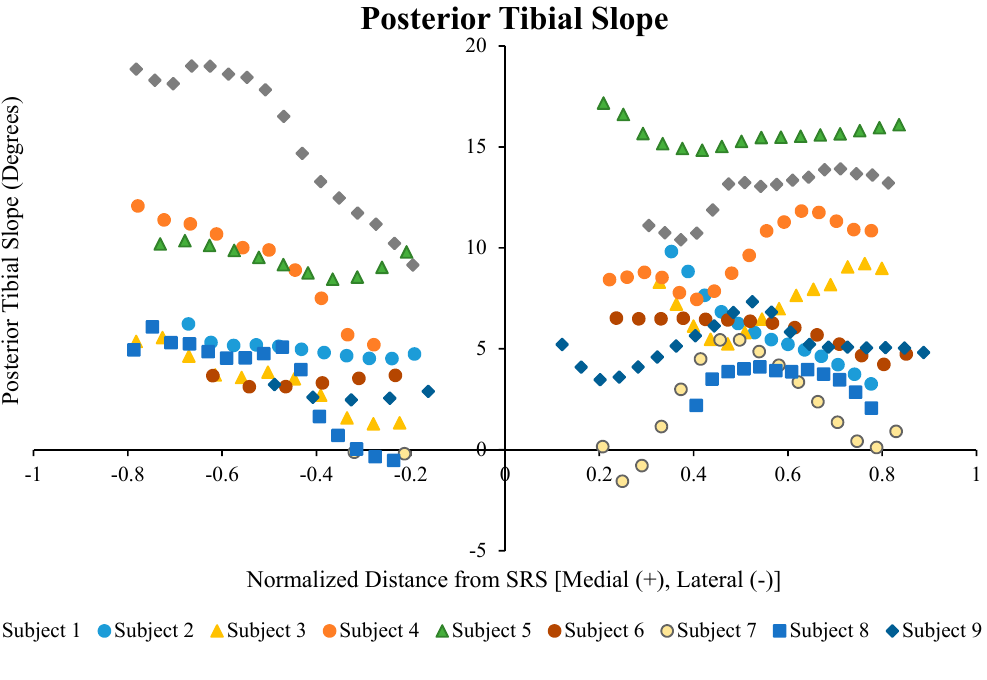
Figure 13. Tibial slopes across the lateral and medial plateaus normalized to the maximum distance to the medial or lateral aspect of the plateau from the sagittal reference slice for each subject. Table 1. The mean (standard deviation) lateral, medial, and coronal tibial slopes, averaged and in the identified concavity zones for each subject.